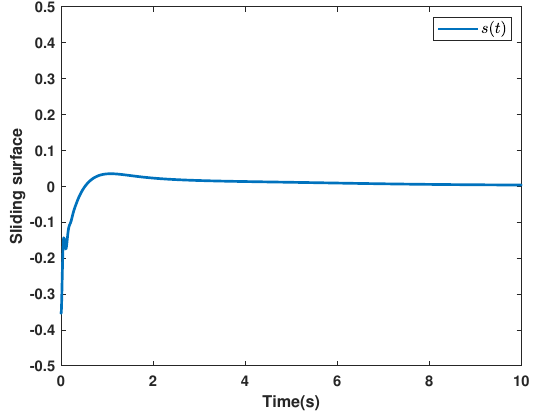
Figure 9. Surface function s ( t )